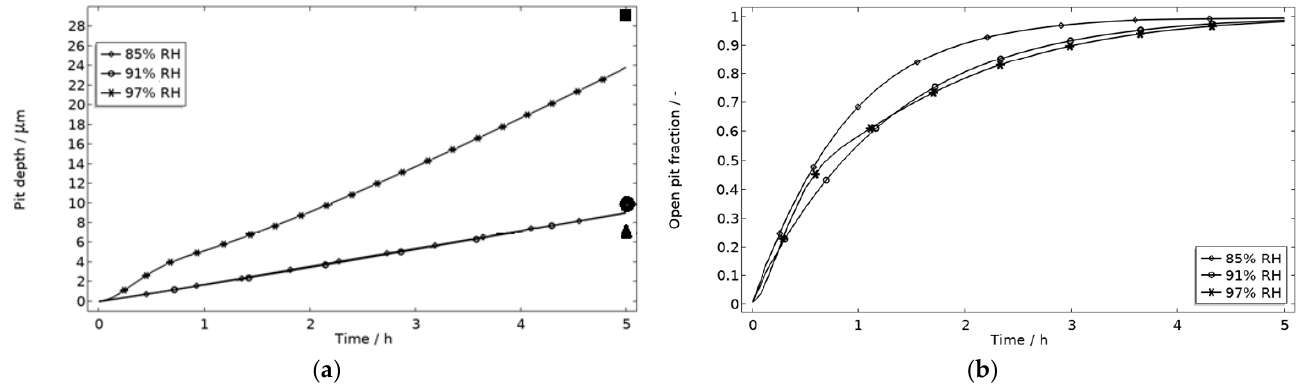
Figure 10. Five-hour exposure of the calibration cell with 86 μg NaCl/cm 2 load at 21 °C at 85%, 91%, and 97% RH. ( a ) Modeled pit depth ( d pit ) with experimental FDPA indicated with triangle, circle, and square at 85%, 91%, and 97% RH, respectively. ( b ) Modeled open pit fraction (χ). During the calibration, it was found that the shape of the galvanic currents could be adjusted using the parameters related to corrosion product precipitation and pit opening.